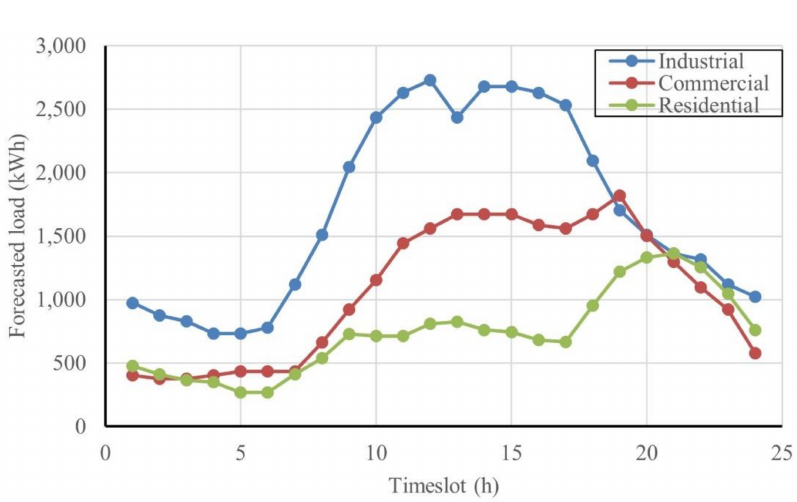
Figure 3. Forecasted industrial, commercial, and residential loads.